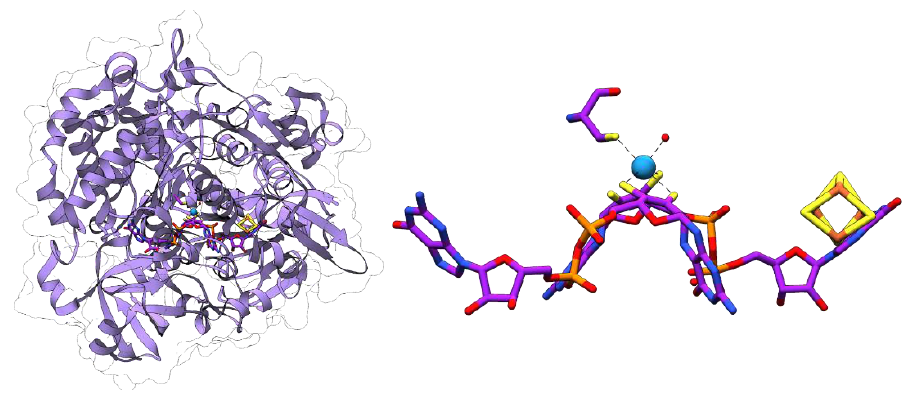
Figure 7. Structure of acetylene hydratase from P. acetylenicus (pdb 2E7Z) at 1.26 Å resolution. Left panel: overall structure. Right panel: W-bis-MGD and [4Fe-4S] cofactors. Tungsten is coordinated by five thiols (four from the dithiolenes and one from Cys141), and by a water molecule. The tungsten atom is depicted in